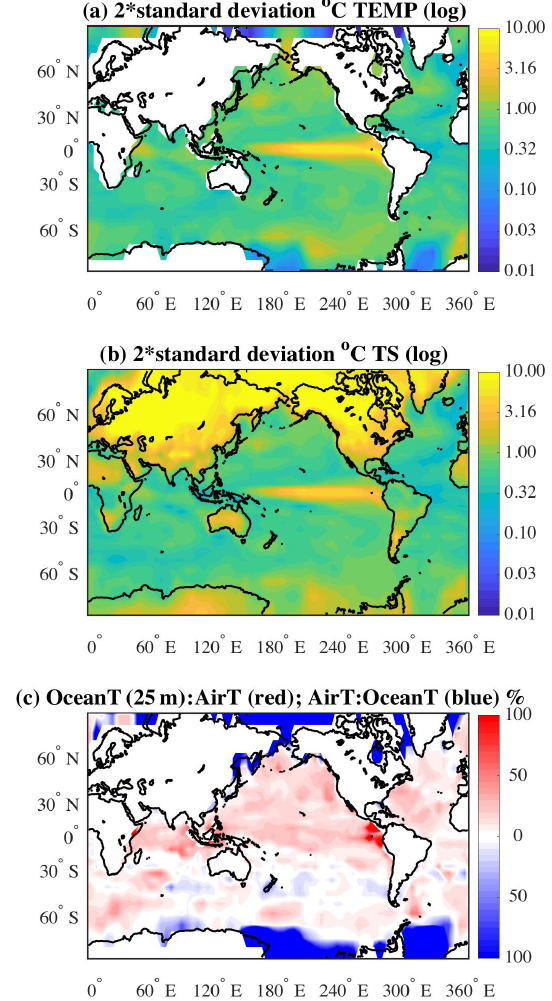
Figure 3. Maps of 2 standard deviations for representing uncer- tainty (2 σ ic ) for December of the 10th year of the simulations in (a) ocean near-surface temperature field at 25m and (b) surface at- mospheric temperature in ◦ C. (The shading is in terms of a log 10 value with tick marks labeled with unlogged values.) The ratio be- tween the two fields is shown in (c) , in which the ratio of the ocean temperature to the atmospheric temperature is given in red as a per- centage. The inverse ratio is given in